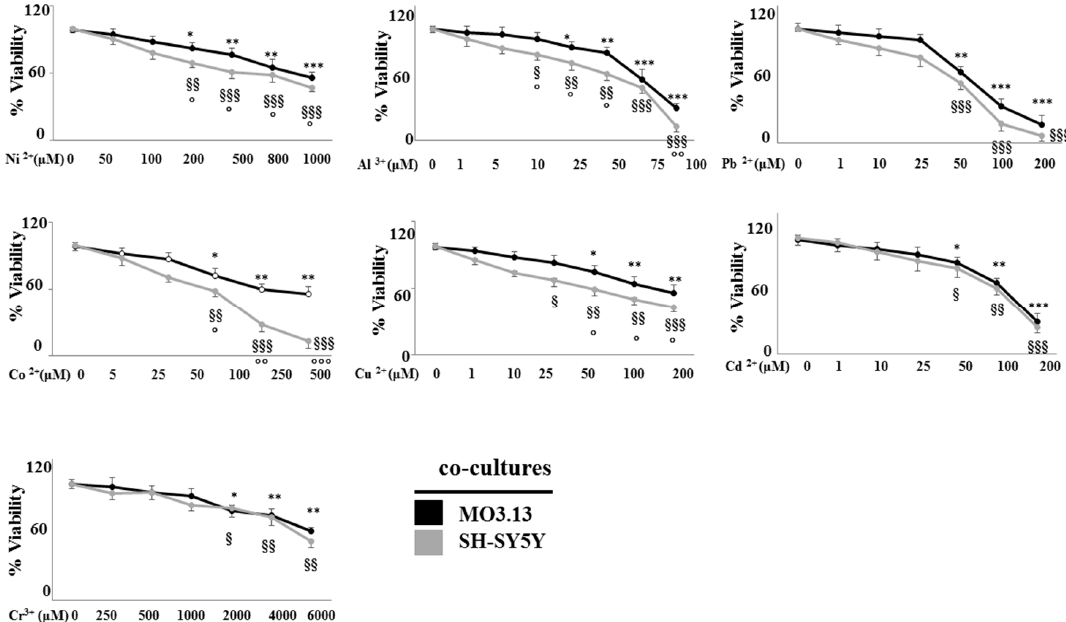
Figure 4. Analysis of cell viability of di ff erentiated oligodendrocytes and neurons grown in co-culture, after the treatment with di ff erent concentrations of heavy metals for 24 h. The cell viability was measured through the MTT assay. Values of three independent experiments are expressed as mean ± standard deviation (sd). * denotes p < 0.05 vs. control; ** denote p < 0.01 vs. control; *** denote p < 0.001 vs. control; § denotes p < 0.05 vs. control; §§ denote p < 0.01 vs. control; §§§ denote p < 0.001 vs. control. ◦ denotes p < 0.05 vs. oligodendrocyte viability under the same treatment conditions; ◦◦ denote p < 0.01 vs. oligodendrocyte viability under the same treatment conditions; ◦◦◦ denote p < 0.001 vs. oligodendrocyte viability under the same treatment conditions Analysis of Variance (ANOVA) followed by the Tukey-Kramer comparisons test). Table 1. The selected concentrations for each heavy metal.